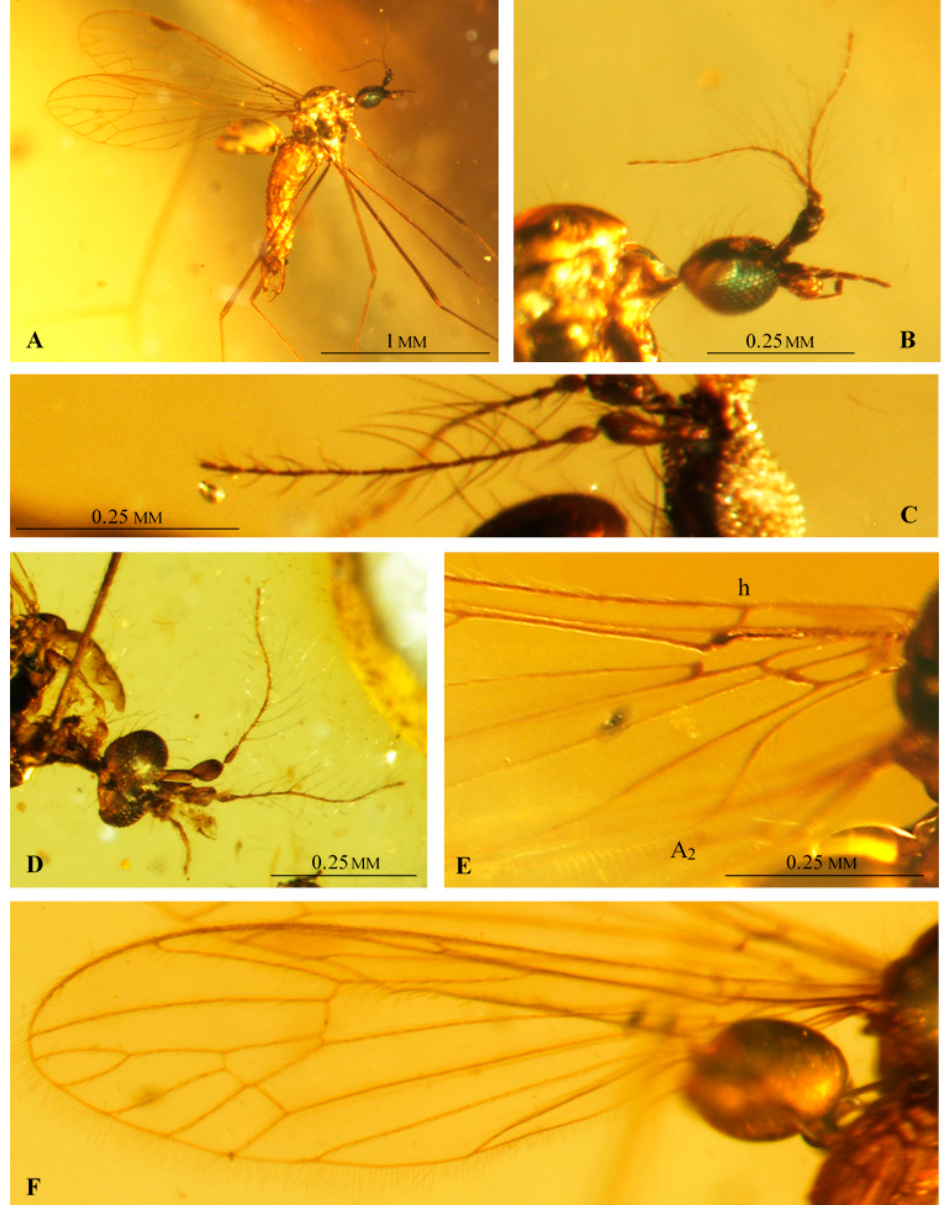
Figure 3. Drinosa prisca Podenas et Poinar, 2009 [13]. ( A ) No . MP/4022, (male) (ISEA PAS), body, lateral view; ( B ) No . MP/4022, (male) (ISEA PAS) head, lateral view; ( C ) No . MP/4068 (male) (ISEA PAS), antenna; ( D ) No . MP/4070 (male) (ISEA PAS), head, latero-ventral view; ( E ) No . MP/4068 (male) (ISEA PAS), base of wing; ( F ) No . MP/4022 (male) (ISEA PAS), wing venation. Thorax brown, wings approximately three times as long as wide without darkened spots except dark, oval pterostigma. Wing venation: Sc ending opposite 1/2 to 2/3 of Rs; sc-r positioned close to or at tip of Sc; arculus absent, Rs almost as long as R 2+3+4 ; R 1 ending just behind half length of R 2+3+4 ; cell r 2+3+4 widely expanded in distal part, distal part of cell r 5 very narrow; crossvein m-m present; crossvein m-cu in distal part of d-cell, rather short and straight; M 1 and M 2 short, petiole of m 1 present; d cell small, trapezoidal; crossvein m-cu in 2/3 of d cell; A 1 long, almost straight; A 2 long, straight, approximately as long as Mb. Legs long, slender, without tibial spurs. Male genitalia differ between the two genera and are presented in the generic